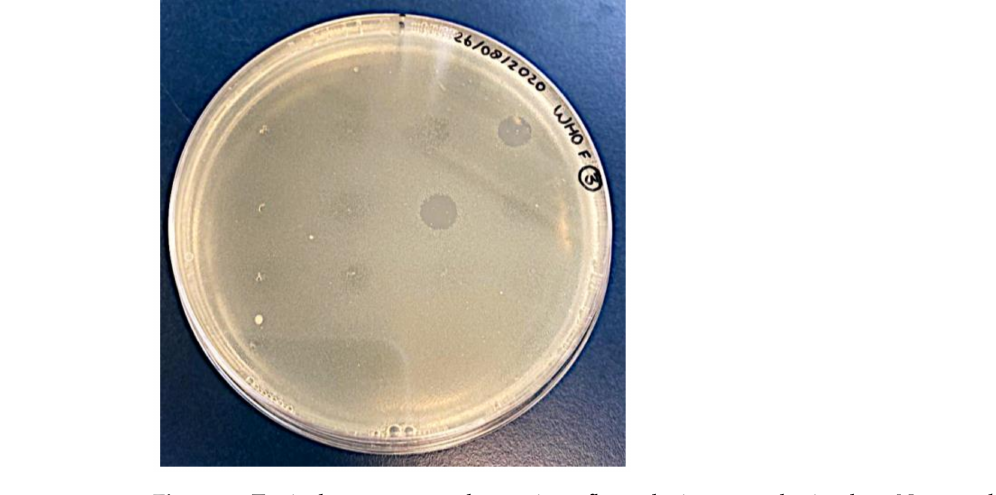
Figure 1. Typical spot test result: semi-confluent lysis zones obtained on N. gonorrhoeae reference strain